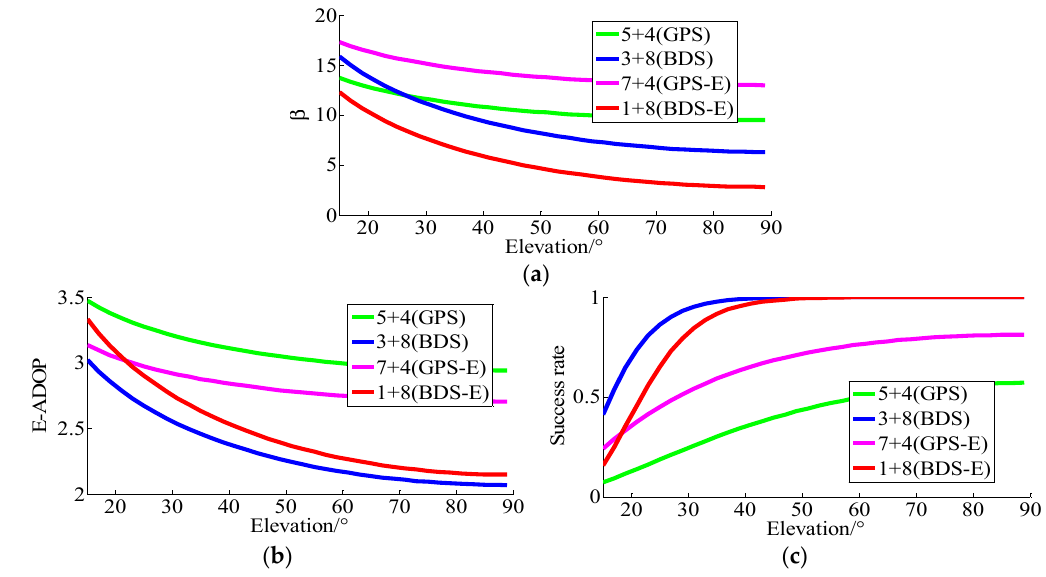
Figure 4. The β , E-ADOP and success rate of GPS, BDS, GPS-E and BDS-E. ( a ) The β of GPS, BDS, GPS-E and BDS-E. ( b ) The E-ADOP of GPS, BDS, GPS-E and BDS-E. ( c ) The success rate of GPS, BDS, GPS-E and BDS-E.